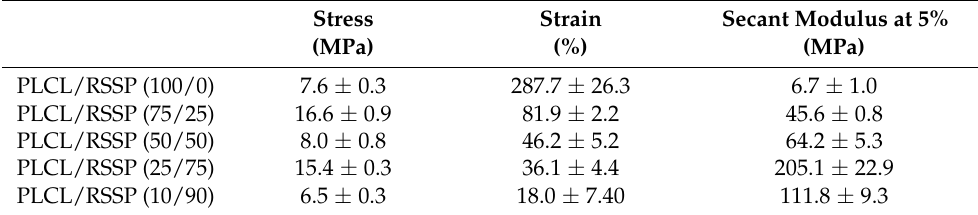
Table 1. Mechanical properties of nanofibrous membranes (4 times for each membrane).